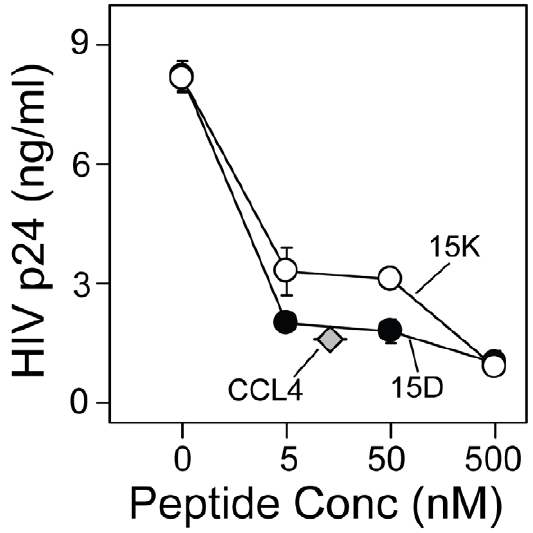
Figure 2. Inhibition of HIV-1 strain JRFL infection of monocyte- derived macrophages by peptides 15K, 15D and chemokine CCL4. Monocyte-derived macrophages were treated with the desig- nated concentrations of peptide for a period of 1 h prior to addition of HIV-1 JRFL . After 2 hr, cells were washed, and viral replication was determined after 72 hr by p24 analysis. Results are representative of 4 independent experiments. The level of replication in the 15D and 15K groups were significantly different (P , 0.01) from the untreated group at concentrations of 5 nM or more.